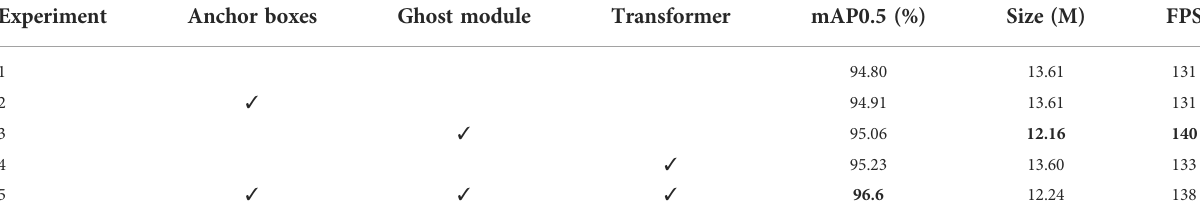
The bolded areas inside the table represent the best